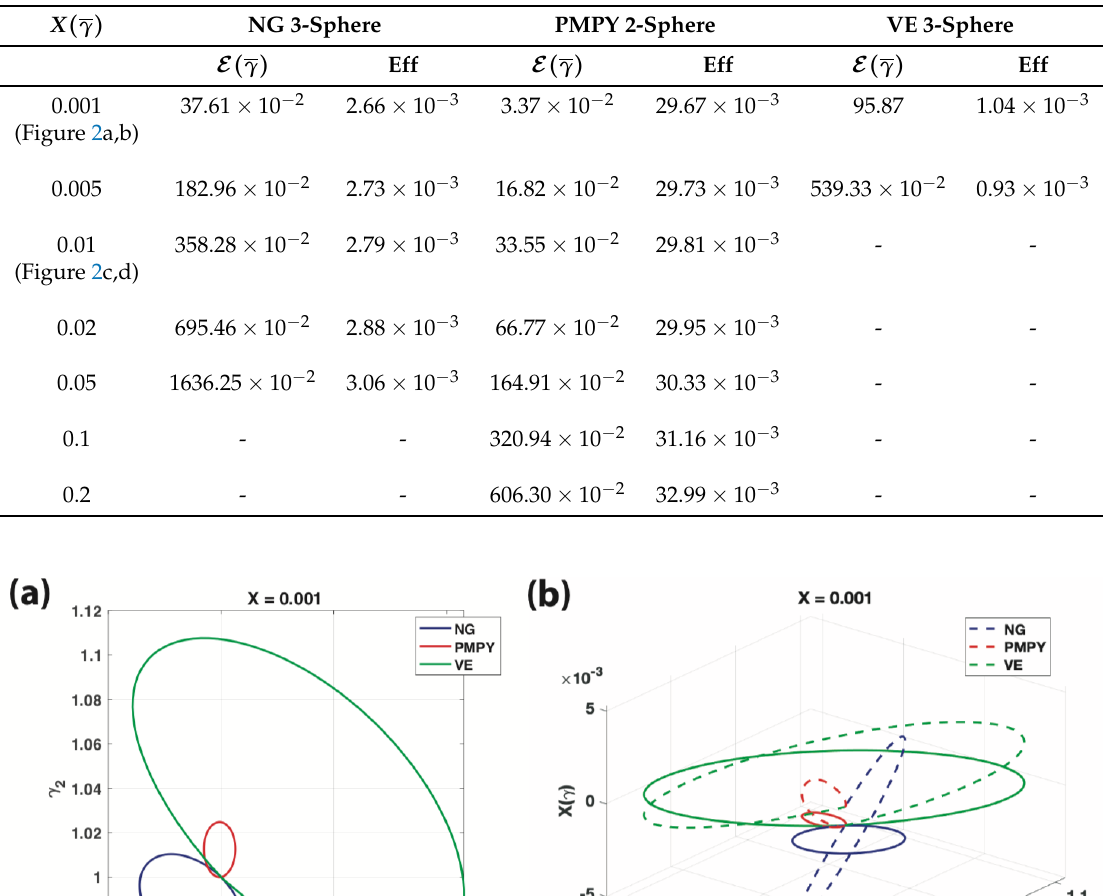
Table 1. Energy dissipation E ( γ ) and efficiency Eff.